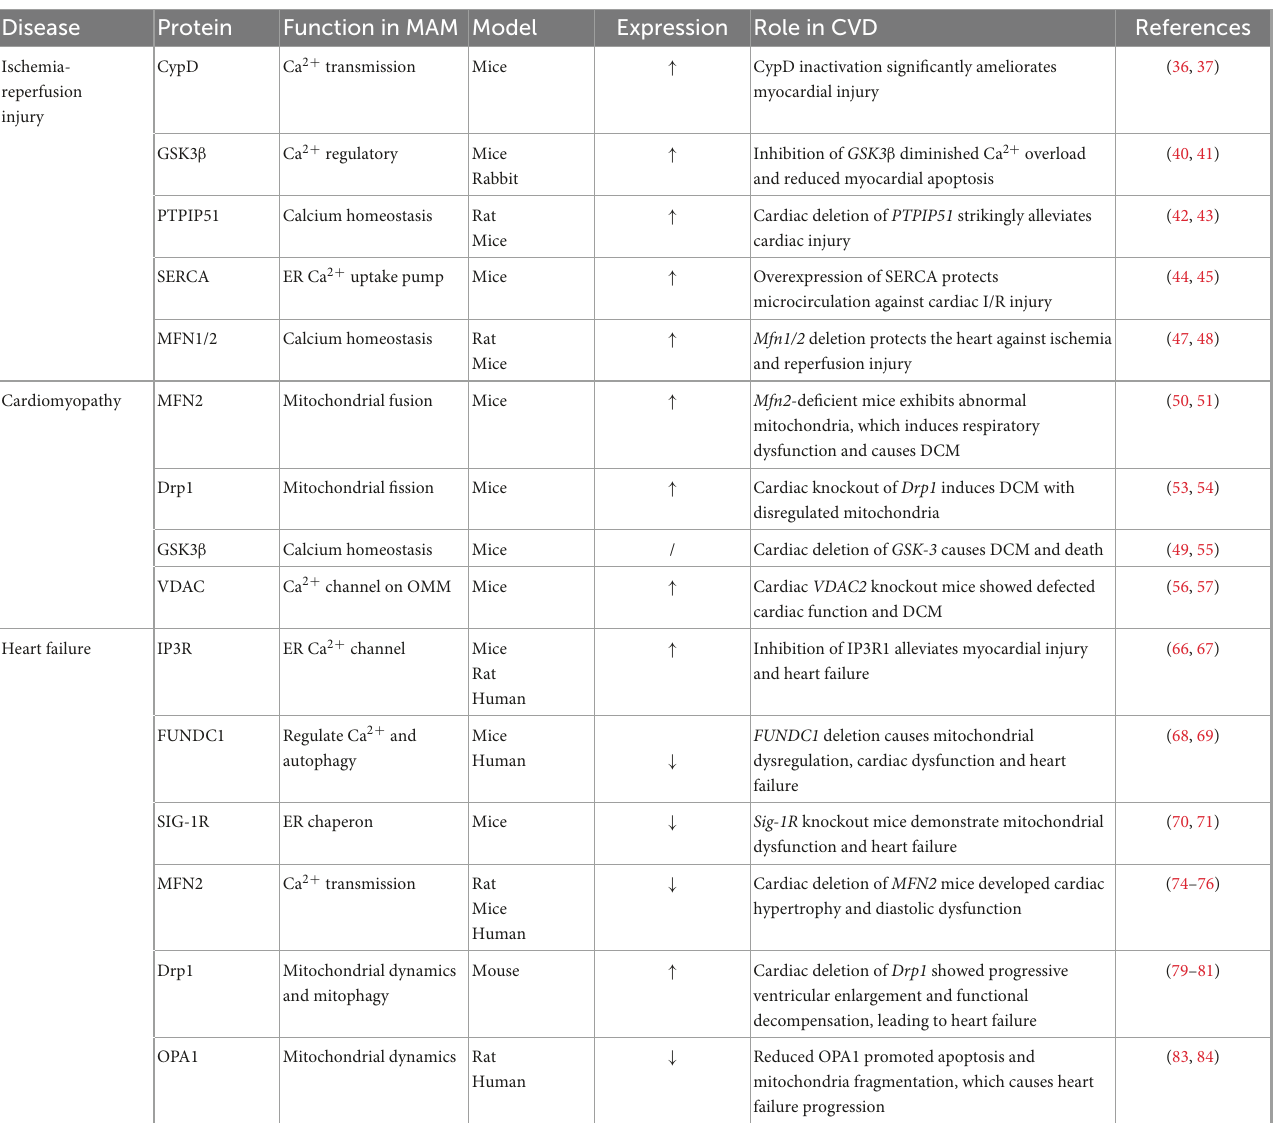
TABLE 1 The roles of MAMs related proteins in CVDs. Disease Protein Function in MAM